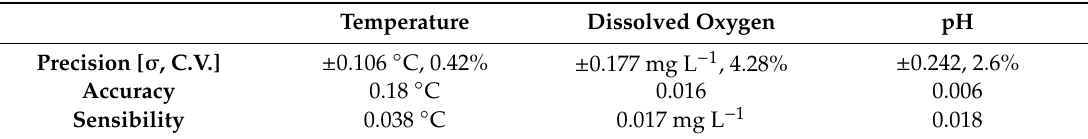
Table 4. Reliability (precision, accuracy, and sensibility) of the proposed low-cost water-quality system ( σ is standard deviation and C.V. coefficient of variation ).